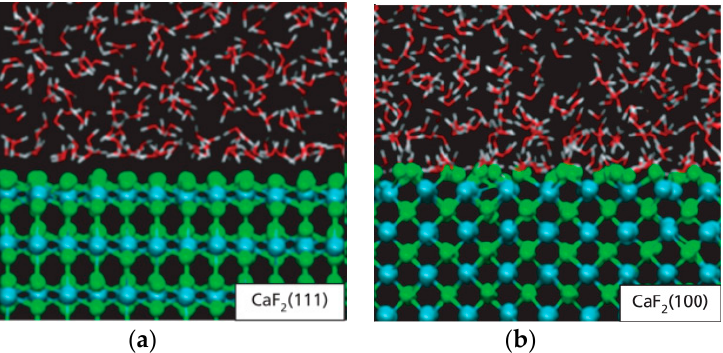
Figure 4. MD simulation snapshot of the equilibrium configuration of water molecules at fluorite (111) surface ( a ) and (100) surface ( b ) (green: fluorine; cyan: calcium). Reprinted from Ref. [37], Copyright 2015, with permission from ICE Virtual Library.